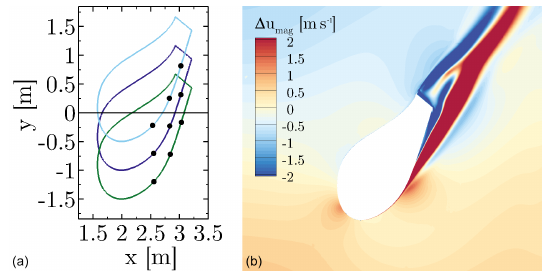
Figure 27. Sketch of the shifted profiles at r/R = 0 . 136 (a) . Difference in velocity magnitude between CaseT1.4-dYm05 and CaseT1.4 (b)